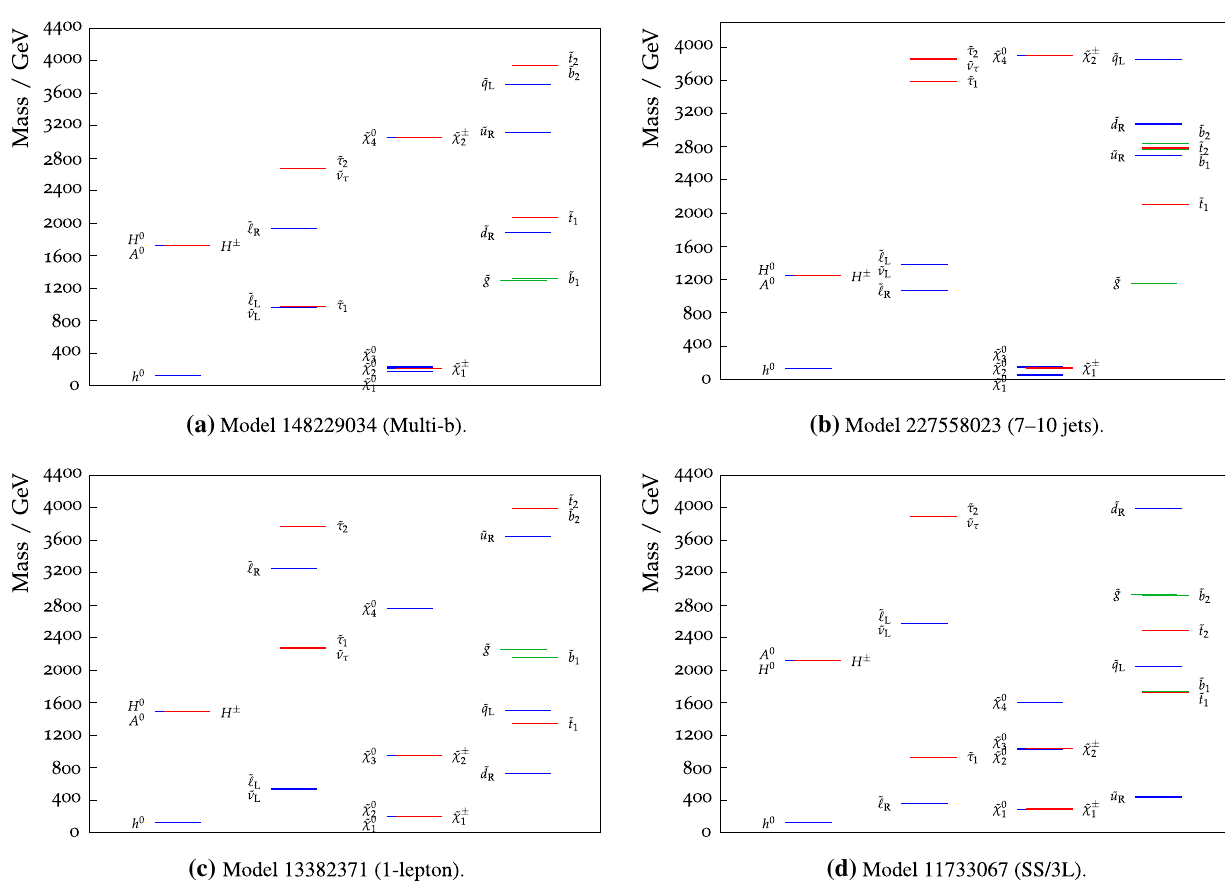
Fig. 15 The same model points as those in Fig. 4 with full mass spectra displayed but without branching ratios for